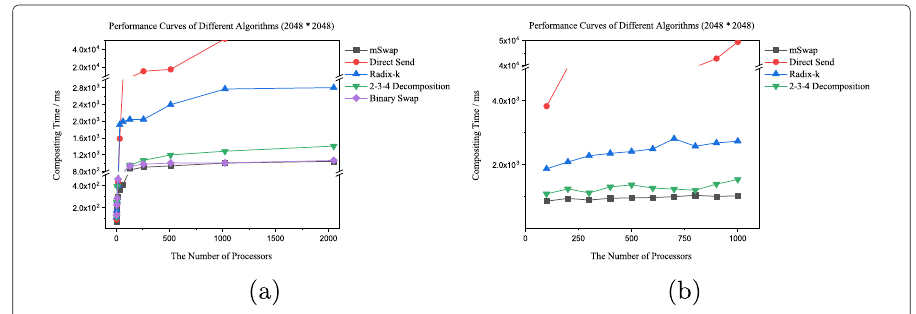
Fig. 9 Performance curves of different algorithms with a resolution of 2048 ∗ 2048. a is the compositing time when the number of processors is power-of-two. b is the compositing time when the number of processors is non power-of-two without Binary Swap